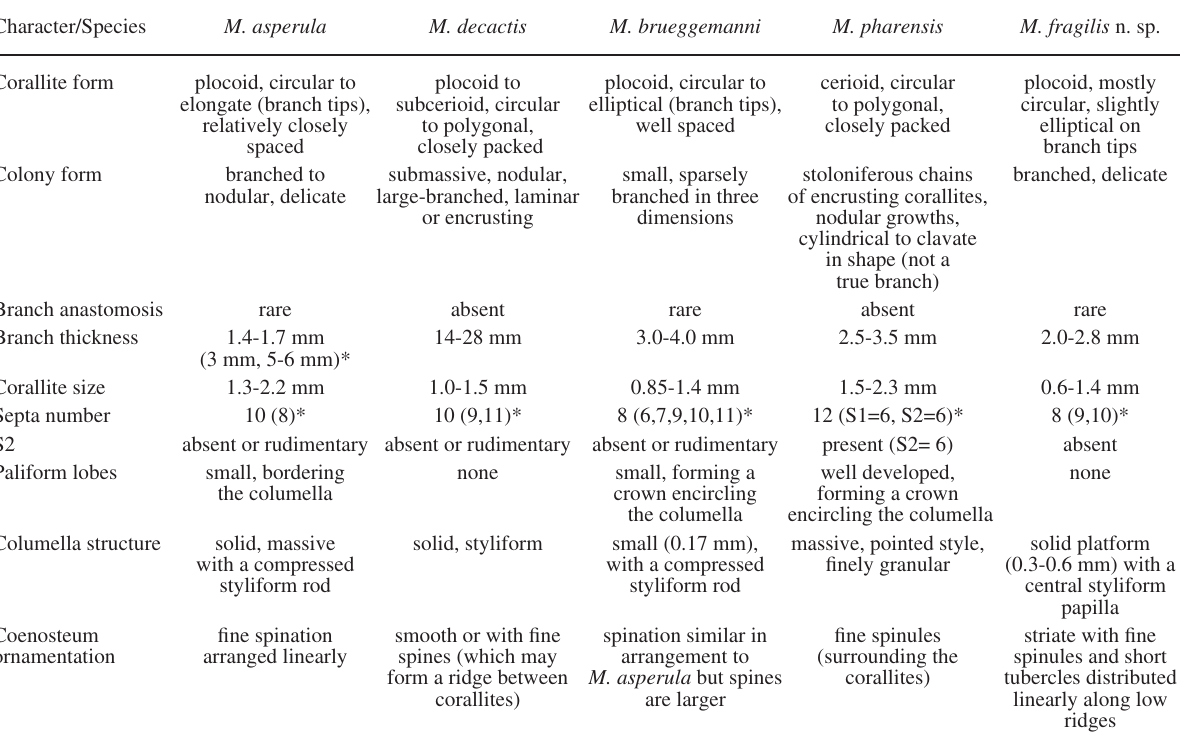
Table 1. – Corallum and corallite diagnostic characters for the identification of southwestern atlantic Madracis (including M. fragilis n. sp.). data summary based on Wells (1973), Fenner (1993), Cairns (2000), veron (2000) and locke et al. (2007). Within parenthesis (*) all possible variable